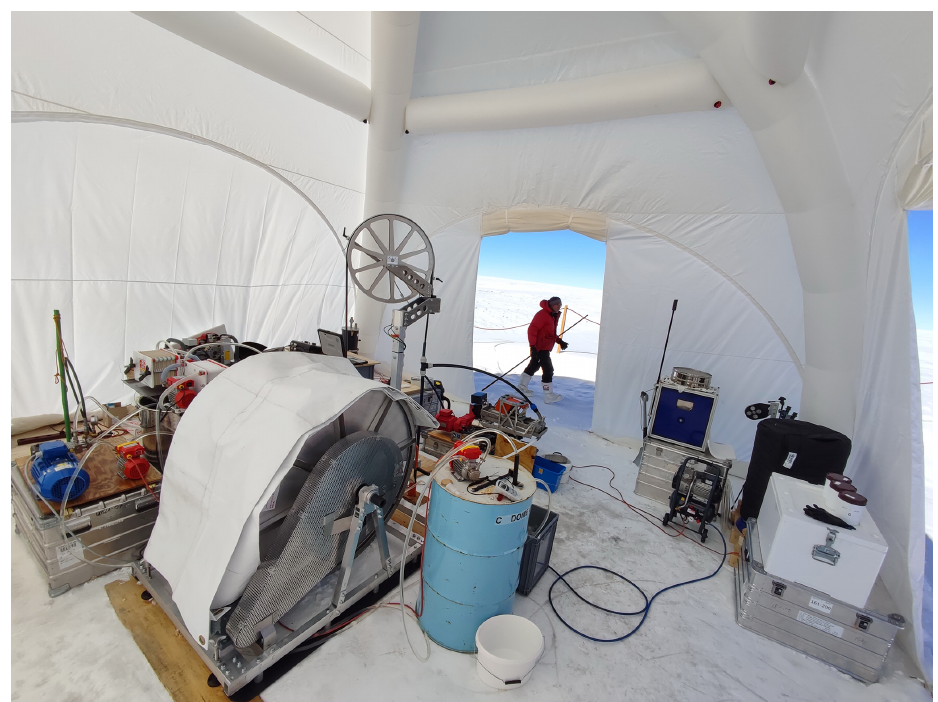
Figure 1. The RADIX system is housed in an inflatable, windproof shelter (dimensions: 7m × 7m × 5m) from AXION (https://www. axion4event.com, last access: 27 February 2023).